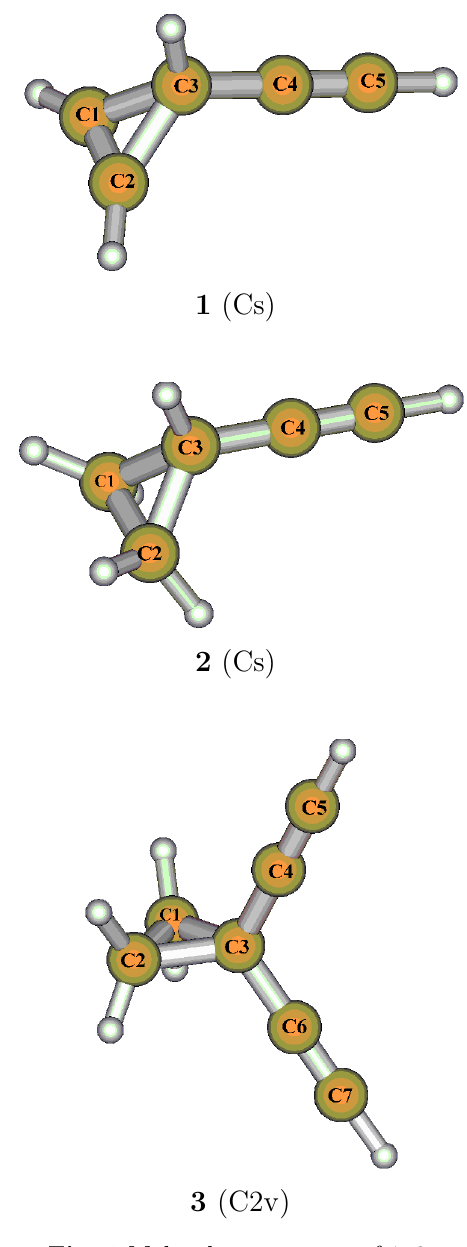
Fig. 1 Molecular structures of